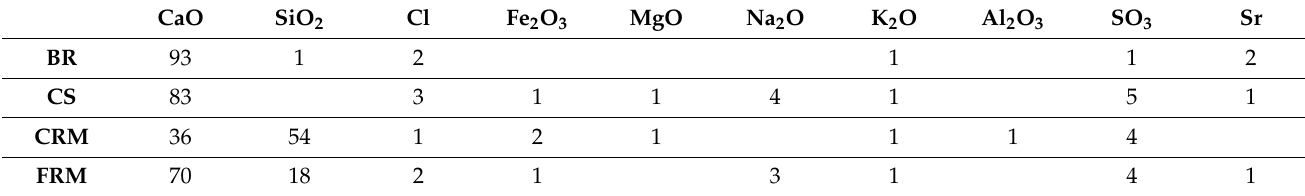
Table 4. Elemental analysis of major and minor elements, expressed in oxides ( wt. %), for the Anfushi’s Necropolis samples. BR: bedrock; CS casting stone; CRM: coarse-grained rendering mortar; FRM: fine-grained rendering